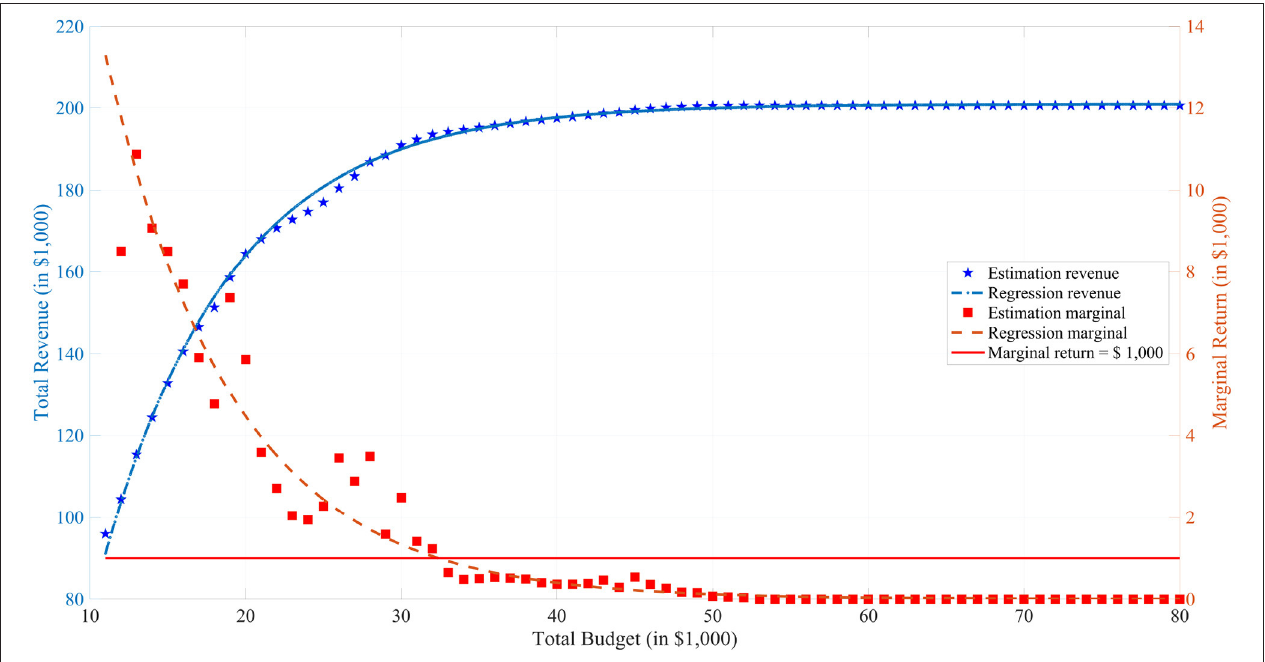
FIGURE 5 | Profits and Budgets. In the figure, the blue pentagrams represent the estimation results from simulations and the blue curve represents a nonlinear regression with model y = a 1 + a 2 × exp( a 3 x ) for the estimation. The red squares represent the difference between the adjacent estimations and the red curve represents the derivative of the expected total revenue curve. The red horizontal line is the marginal return is equal to one unit increment of total budget, which is $1,000.